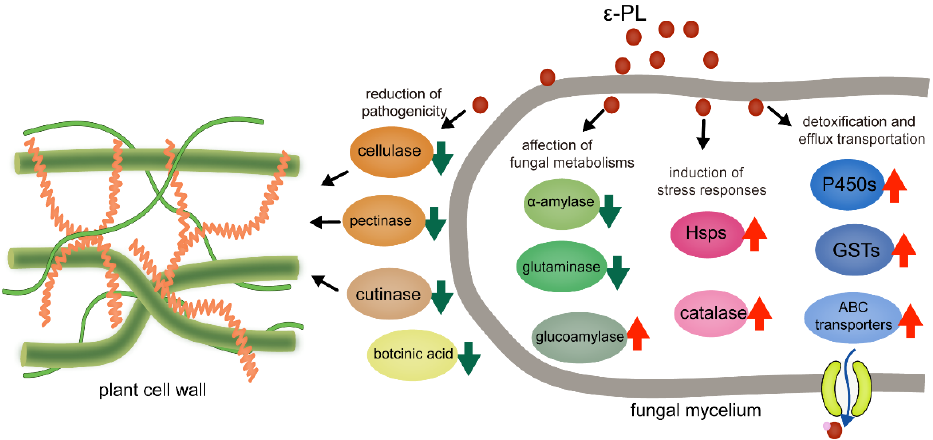
Figure 7. Model for regulation of critical genes involved in fungal metabolisms, pathogenicity, stress responses and detoxification by ε -PL treatment of two necrotrophic fungi. Supplementary Materials: The following are available online at www.mdpi.com/xxx/s1, Figure S1: Histogram GO enrichment of DEGs (a) S. sclerotiorum (b) B. cinerea , Table S1: Inhibitory effect of ε -PL against S. sclerotiorum and B. cinerea in vitro, Table S2: Read numbers aligned onto the S. scle- rotiorum (Ss) and B. cinerea (Bc) genome by Illumina sequencing, Table S3: Total DEGs of ε -PL-responsive S. sclerotiorum transcriptome, Table S4: Total DEGs of ε -PL-responsive B. cinerea transcriptome, Table S5: Nucleic acid sequences of oligonucleotide primers used in RT-qPCR analysis.